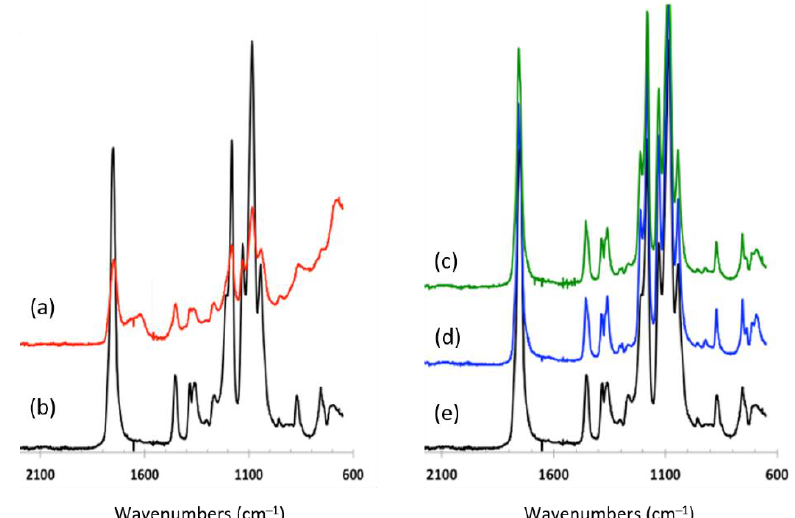
Figure 10. ATR-FTIR spectra of PLLA fibres. On the left: ( a ) Al 2 O 3 infiltrated PLLA fibres (red) and ( b ) uncoated fibres (black). On the right: ( c ) infiltrated DEZ (green), ( d ) infiltrated ZnO (blue) and ( e ) uncoated fibres (black).